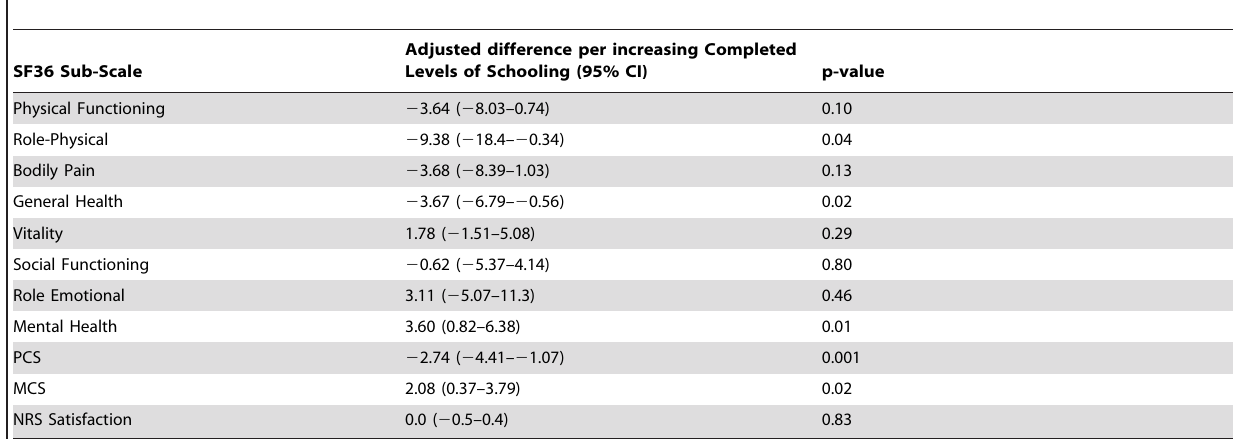
Table 7. Adjusted Difference in Improvement in Health-Related Quality of Life and Satisfaction after Knee Replacement: A Comparison Between Patients with different Completed Levels of